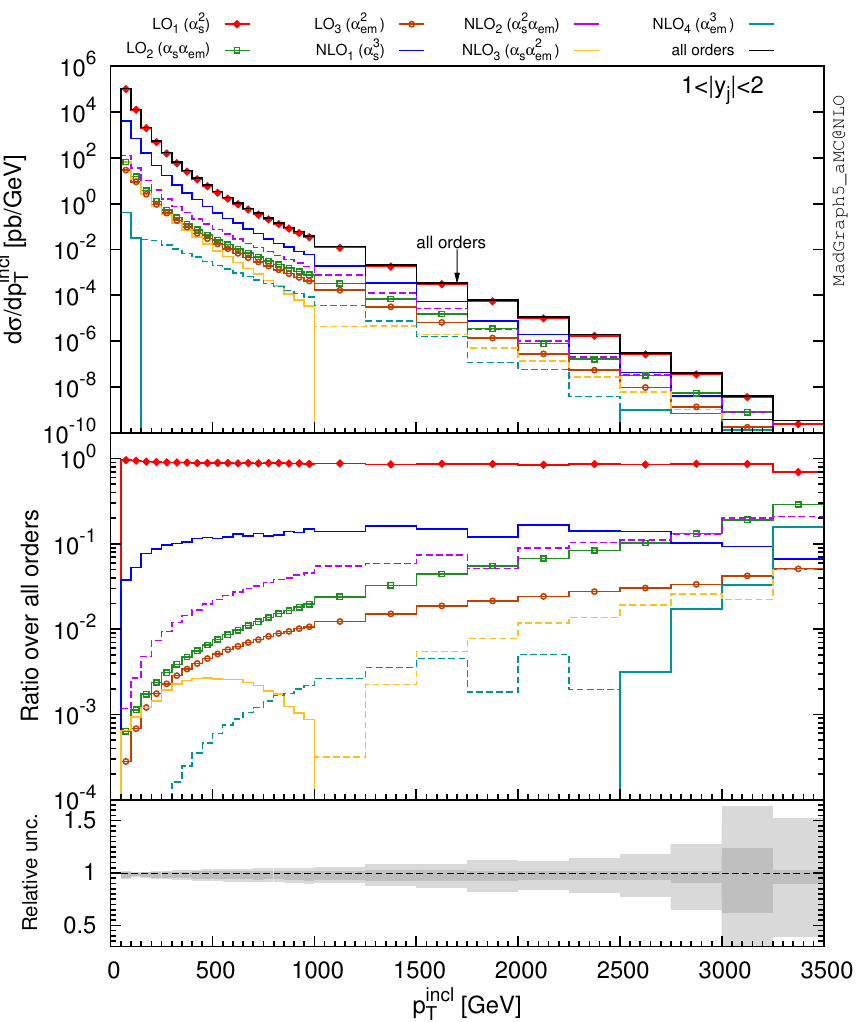
Figure 6 . Single-inclusive transverse momentum, for 1 < j y j (cid:20)